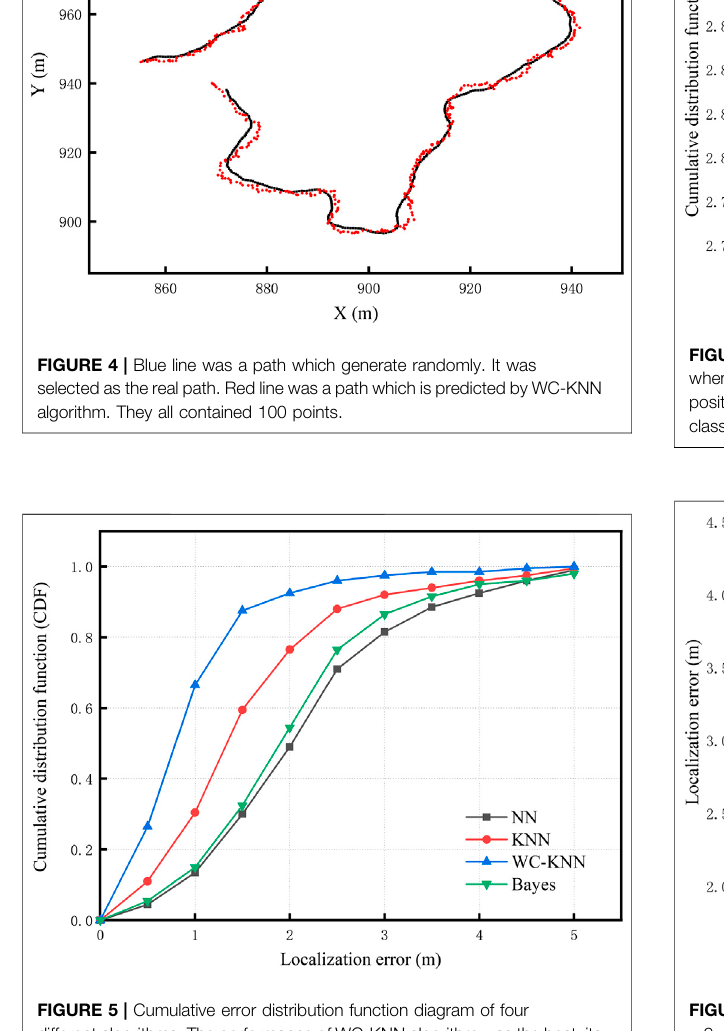
Frontiers in Physics |